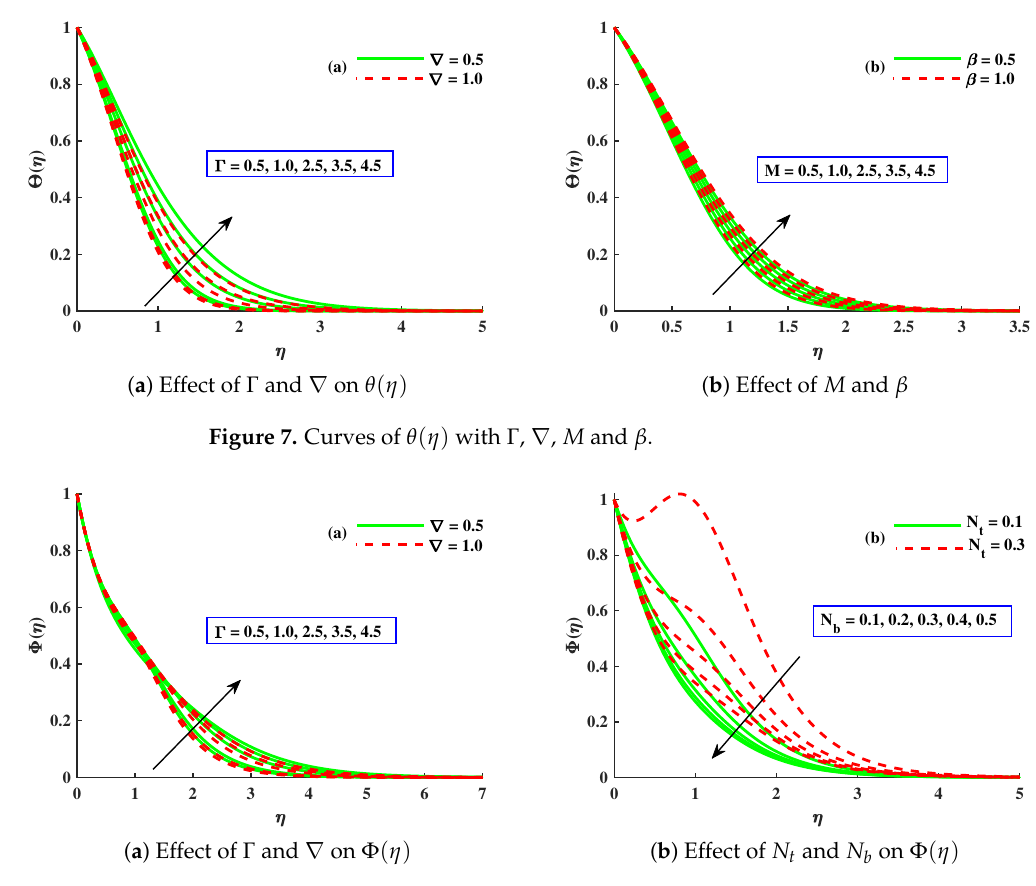
Figure 8. Curves of Φ ( η ) with Γ , ∇ , N t , and N b